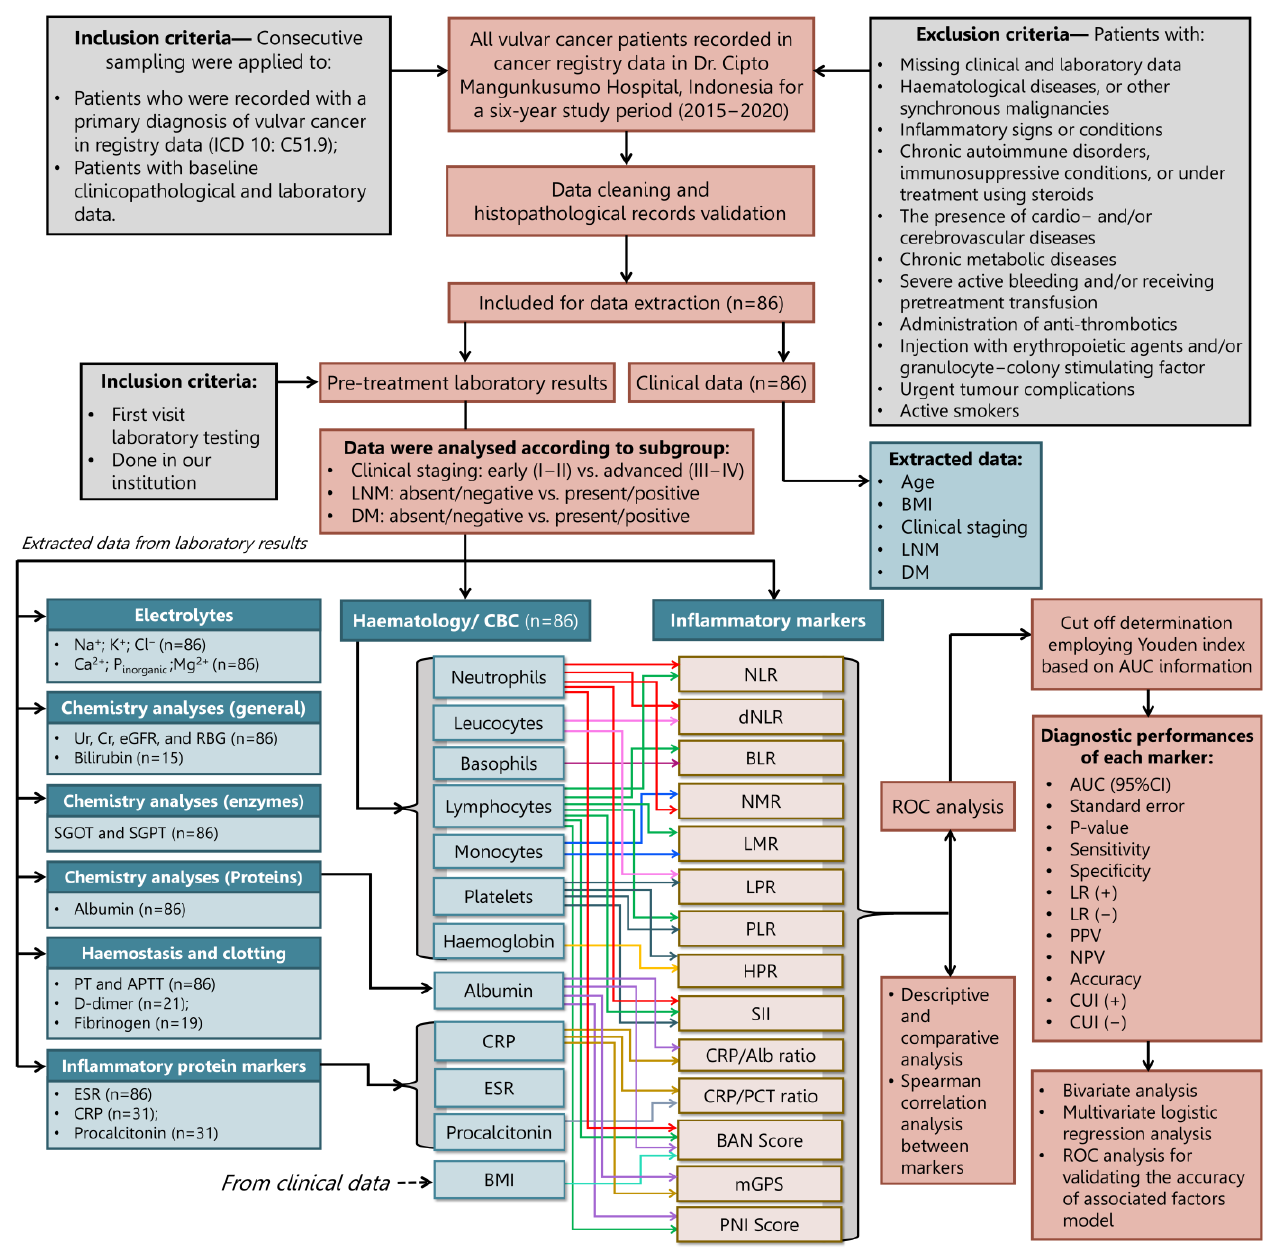
Figure 1. The study workflow describes patient enrolment and inclusion, followed by the analytical data pipeline of subgrouping according to the patient’s clinical staging, lymph node metastasis, and distant